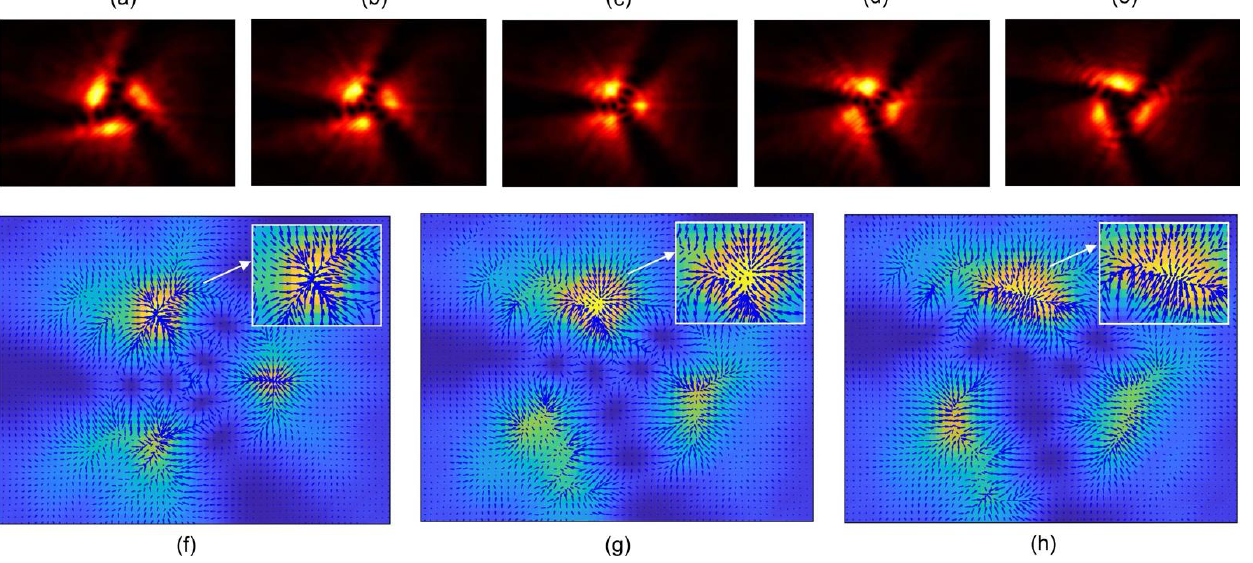
Figure 6. ( a ) to ( e ) Far field images of 𝑍 31 obtained from the experimental setup 3. ( a ) and ( b ) corresponds to 4 and 2 inches before the focus, respectively. ( c ) is the focus image, while ( d ) and ( e ) represents the image 2 and 4 inches post focus. ( f ) intensity gradient of image ( c ) and an example of zoomed region. ( g ) intensity gradient of image ( d ). ( h ) intensity gradient of image ( e ).